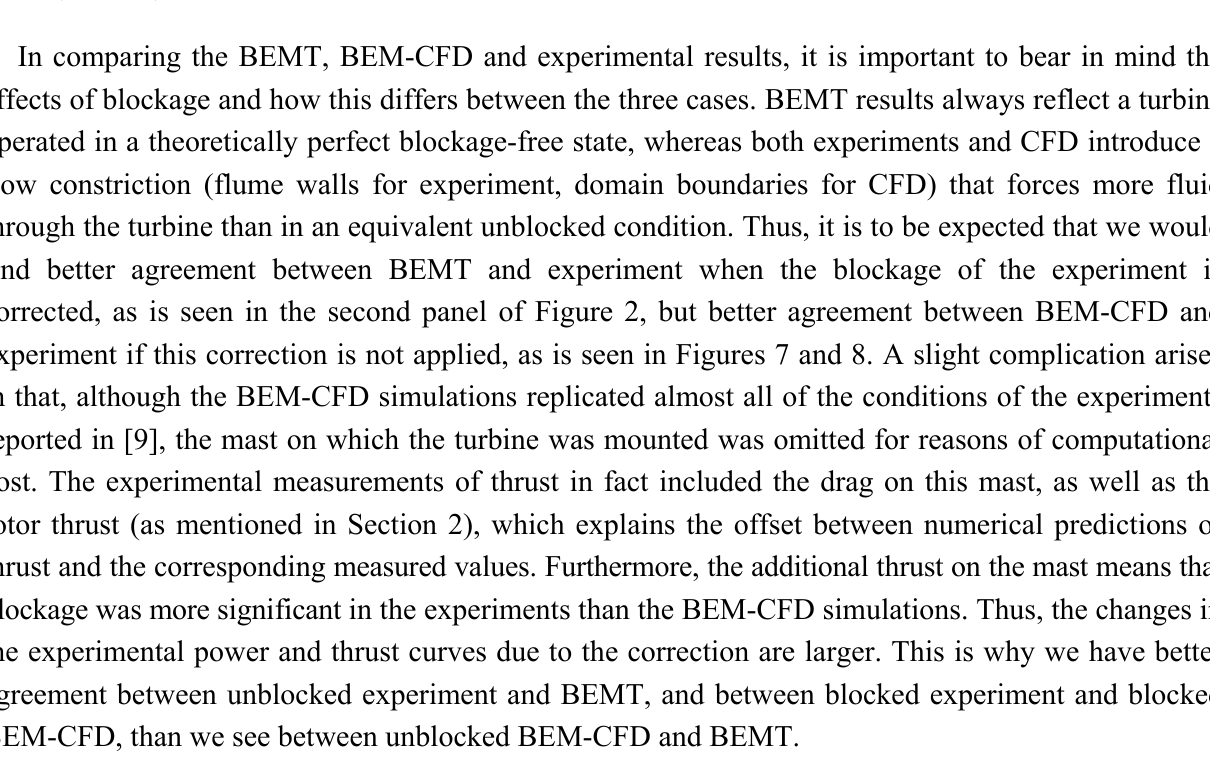
Figure 4. Comparisons of the velocity deficit between BRG ( top right ) and BEM-CFD ( top left ) and between turbulent kinetic energy (TKE) for BRG ( middle ) and BEM-CFD ( bottom ) in the Cardiff 10-m rotor